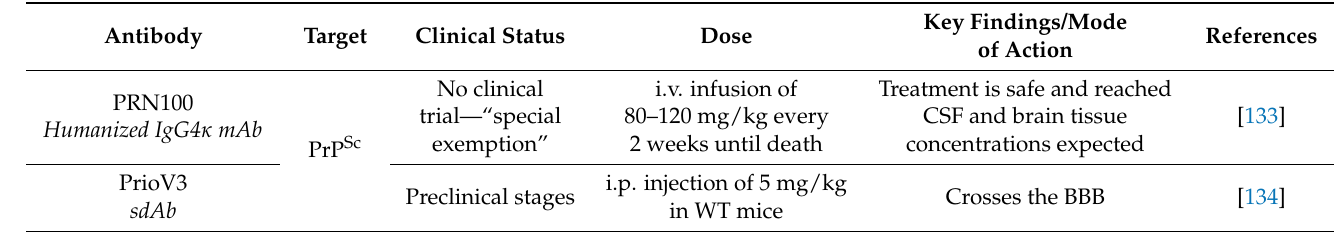
Table 6. Tested antibodies for Creutzfeldt-Jakob’s disease. i.p.,